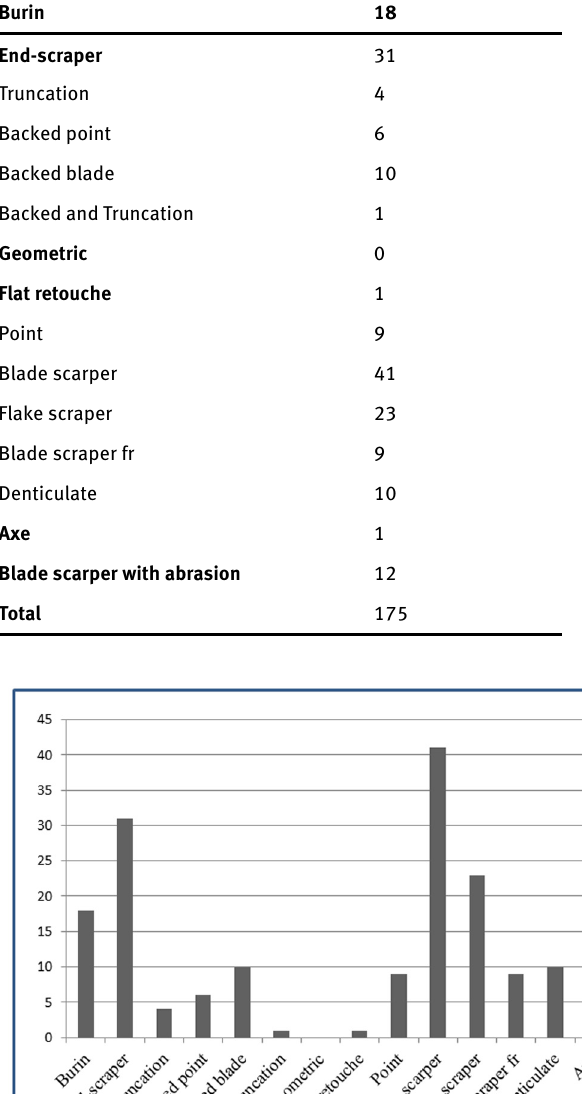
Table 4. Lipari, Contrada Diana trench XVII. Tools.